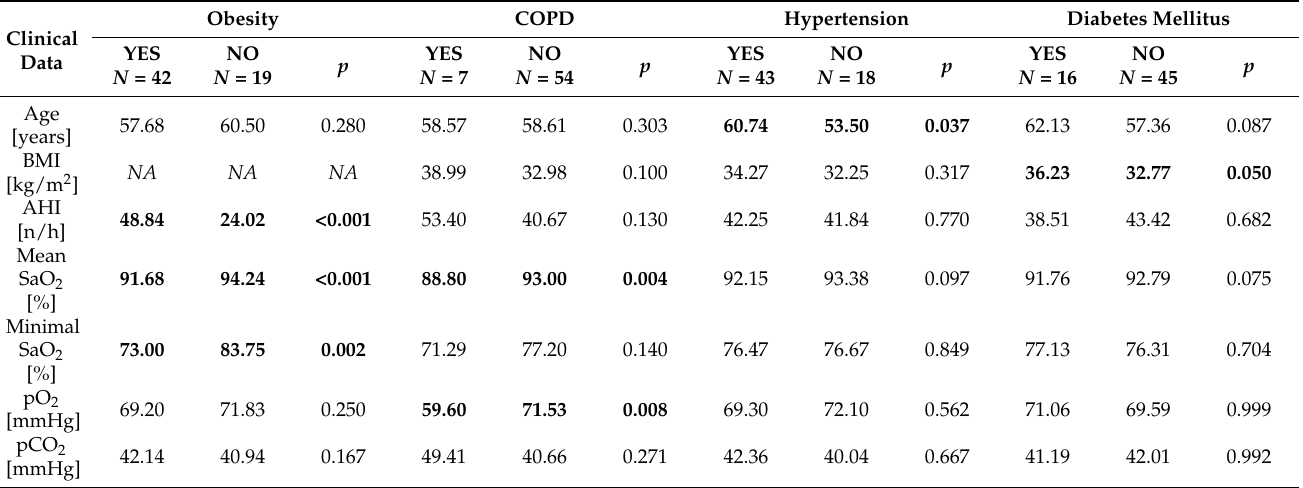
Table 1. The comparison of clinical data in the groups of OSA patients with and without comorbidities. Clinical